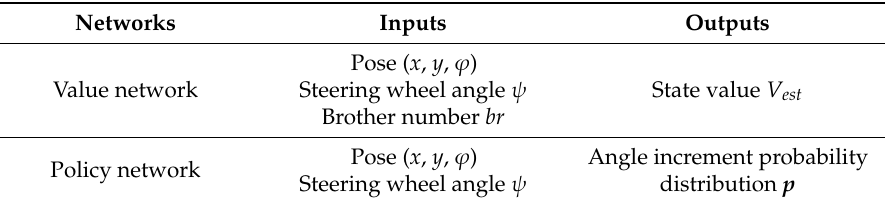
Table 1. The inputs and outputs of artificial neural networks